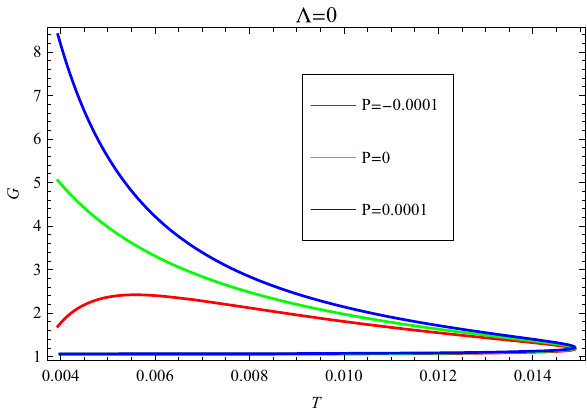
Fig. 6 Plot of Gibbs free energy versus temperature for second case when (cid:2) = 0 , Q m = 2 of the non-minimal